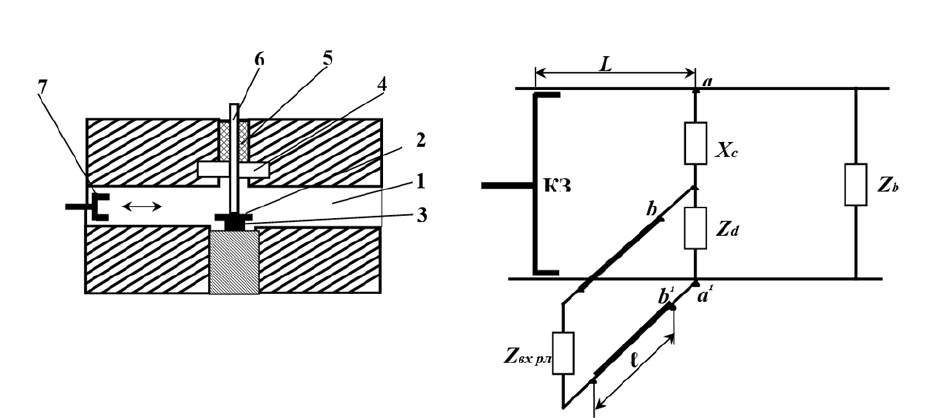
Fig. 1. IMPATT diode generator with radial resonator design scheme and equivalent